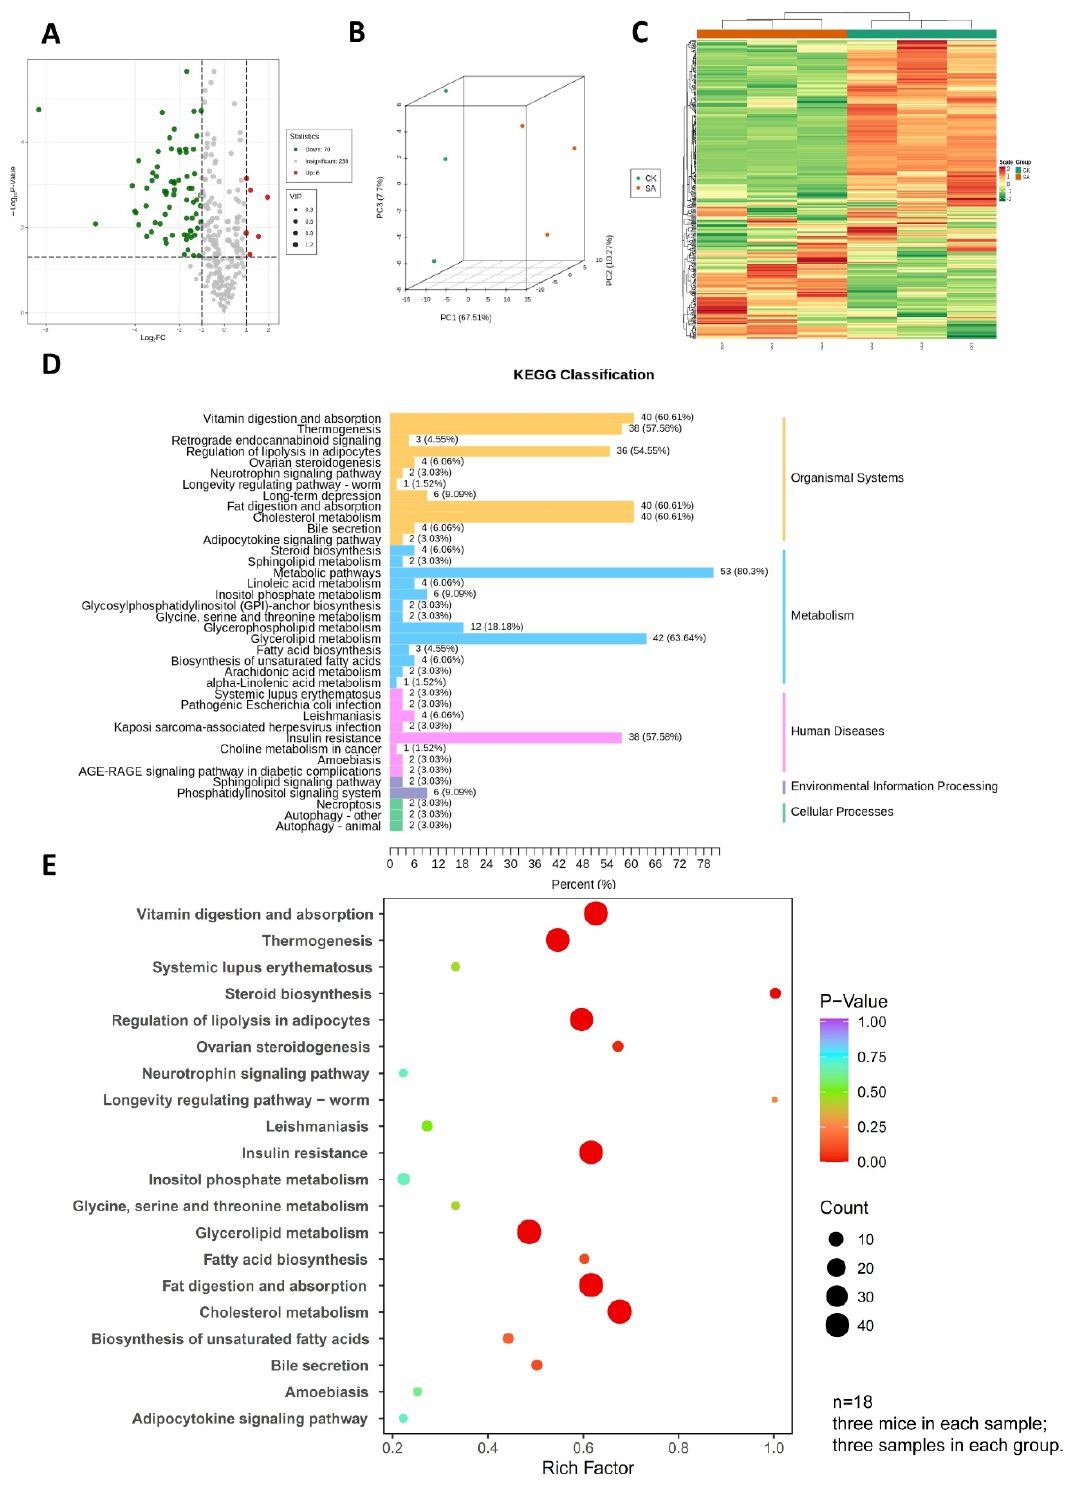
Figure 3. Lipidomic analysis of spleen dendritic cells in control and shrimp allergy groups. ( A ) volcano plot of the 314 lipids profile; ( B ) principal component analysis of the global spleen dendritic cells’ lipidome demonstrated that the two groups (shrimp allergy vs. normal spleen den- dritic cells) were clearly distinguished; ( C ) hierarchical clustering heatmap of lipids in normal and shrimp allergy spleen dendritic cells; ( D , E ), KEGG pathway enrichment showed the most altered lipid metabolic pathways in shrimp